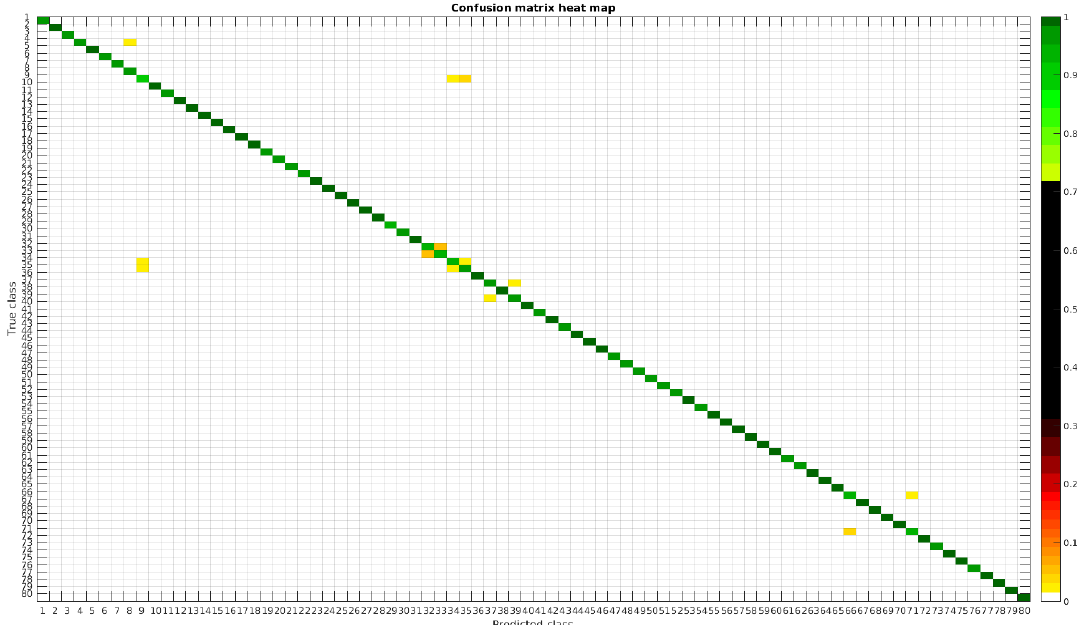
Figure 20. Confusion matrix heat map for the merged dataset with 1000 samples per